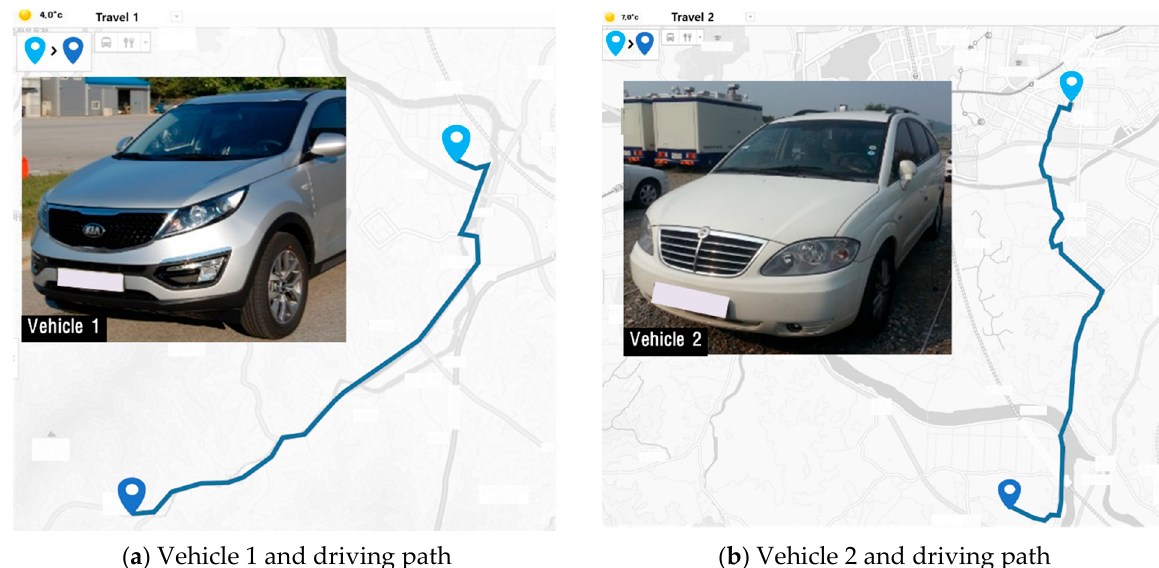
Figure 3. Driving route of the actual vehicle: ( a ) vehicle 1 and ( b ) vehicle 2. Table 1. Information on the vehicles and passengers for actual driving.